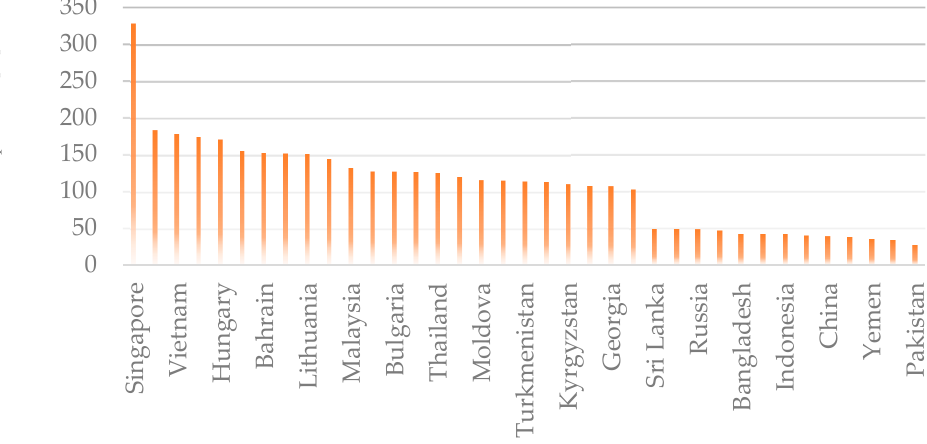
Figure 7. BRI countries’ trade openness in 2015.